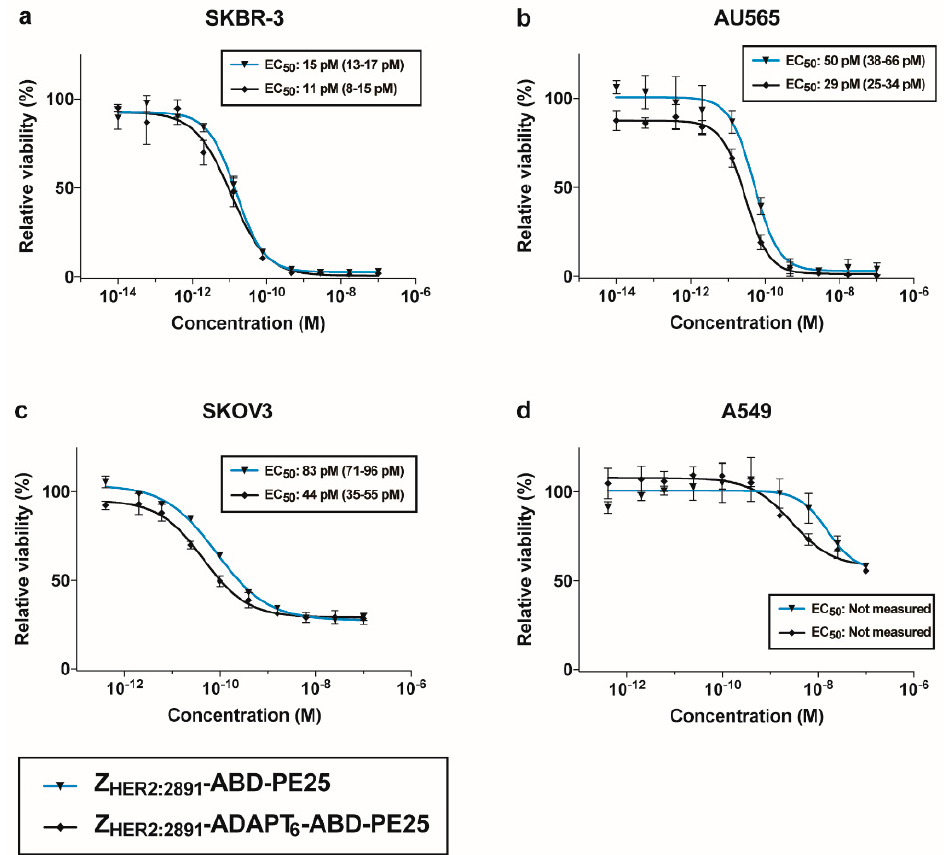
Figure 4. Determination of cytotoxic potency of fusion toxins. SKBR-3 ( a ), AU565 ( b ), SKOV3 ( c ) and A549 ( d ) cells were incubated with di ff erent concentrations of the fusion toxins and the viability of the cells was measured as a function of protein concentration. The viability of cells incubated without toxin (control cells) was set to 100%. The measured viability was plotted as percent viability compared to control cells on the y-axis, as a function of the concentration of fusion toxin on the x-axis. Each data-point corresponds to the average viability of four independent experiments. The error bars correspond to 1 SD.